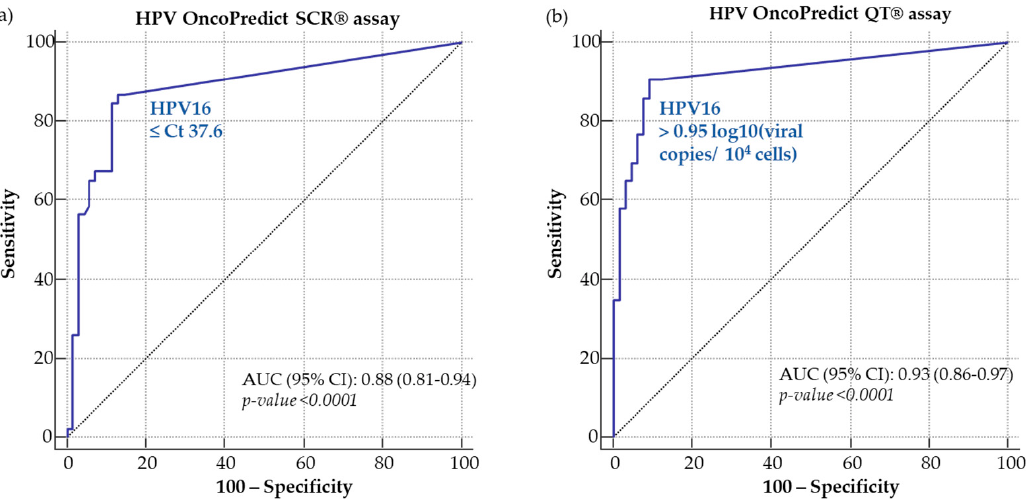
Figure 2. ROC curve analysis for the definition of cutoffs of HPV16 for OncoPredict HPV ® SCR ( a ) and QT ( b ) assays.